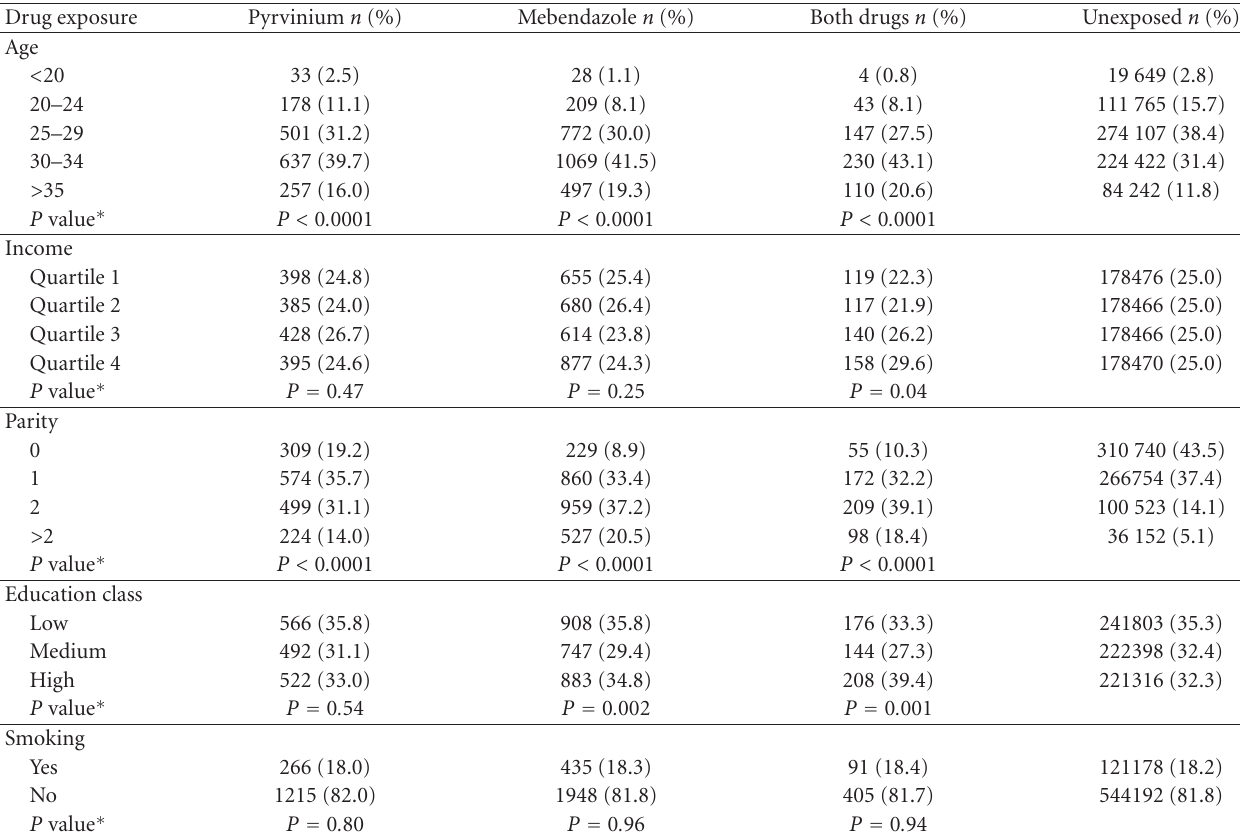
Table 1: Characteristics of exposed and unexposed